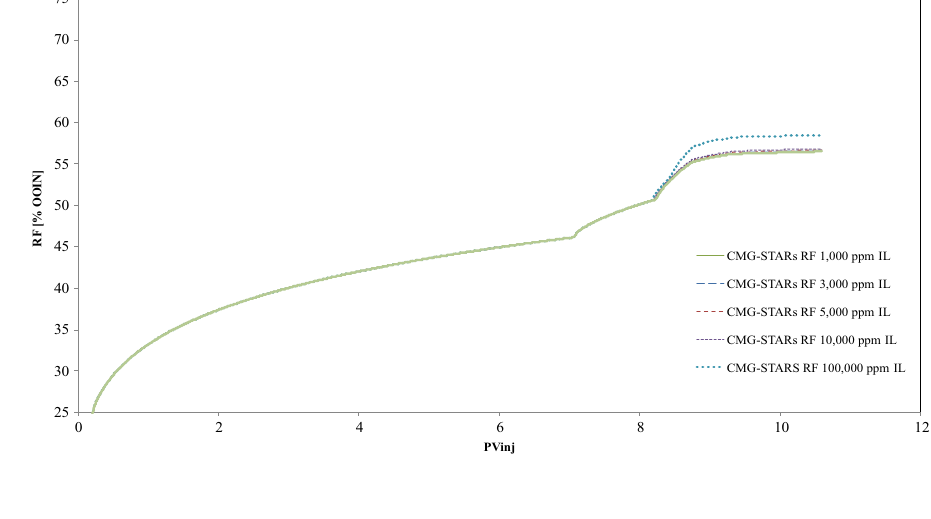
Fig. 16 Effect of [EMIM][Ac] concentration on the